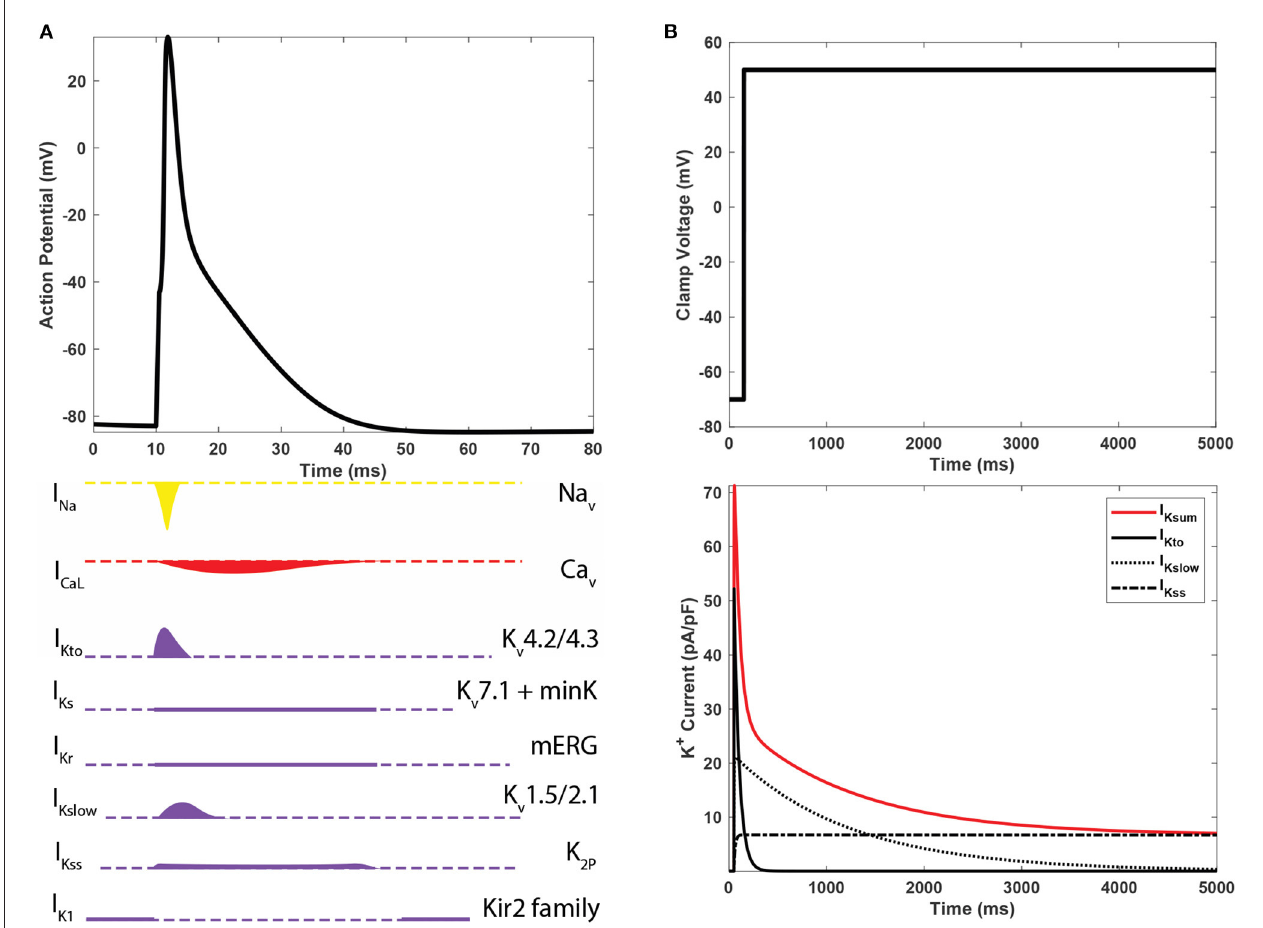
FIGURE 2 | (A) The action potential of mouse ventricular myocytes and underlying ioninc currents. (B) Predominant K + currents in mouse cardiomyocytes and their shapes of whole-cell voltage clamp recordings.